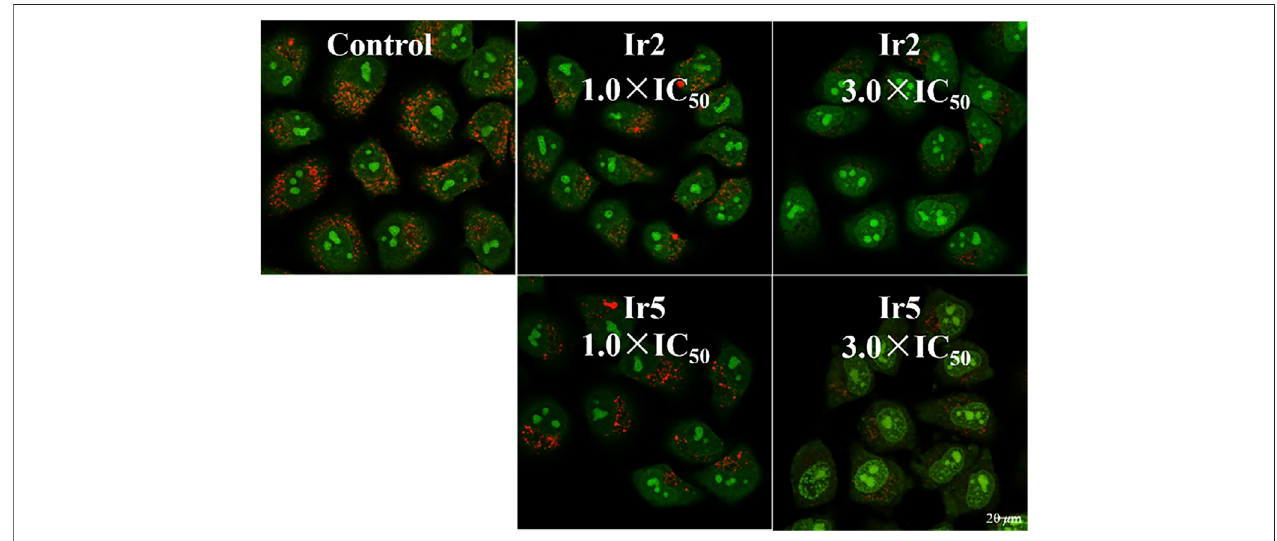
FIGURE 5 | Confocal microscopy images of A549 cells stained with AO (5 μ M, 15 min) after hatched with Ir2 or Ir5 at 310 K. AO excitation at 488 nm; Emission: 510 ± 20 nm (green) and 625 ± 20 nm (red).